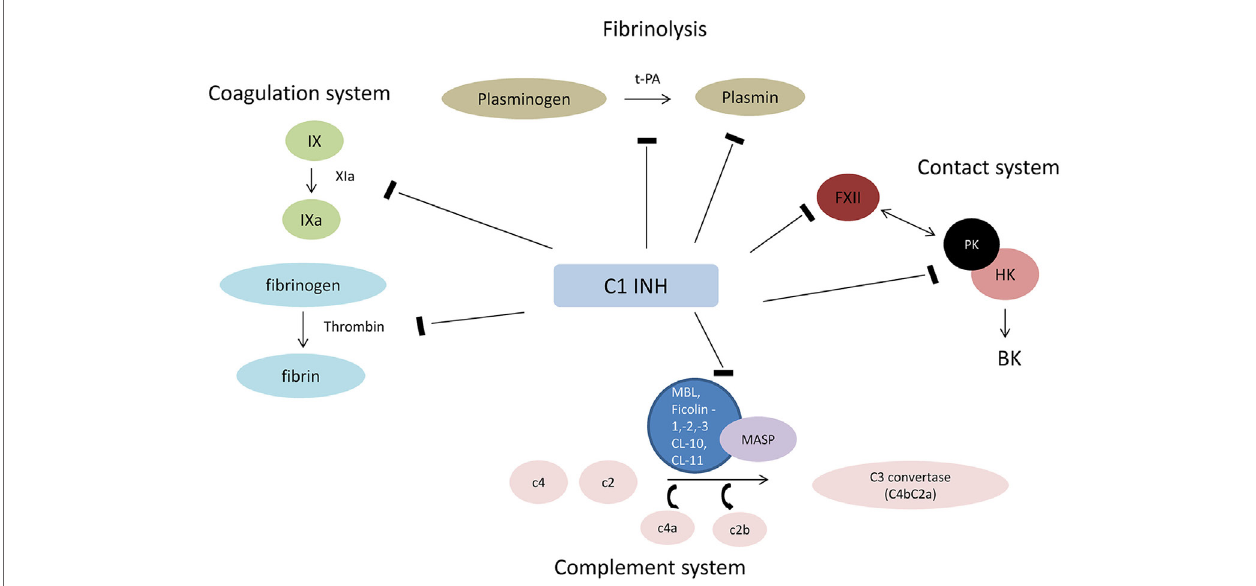
FigURe 1 | Interaction of C1INH with plasmatic cascades. Abbreviations: HK, high molecular weight kininogen; FXII, factor XII (Hageman factor); PK, prokallikrein; BK, bradykinin; t-PA, tissue plasminogen activator; MAC, membrane attack